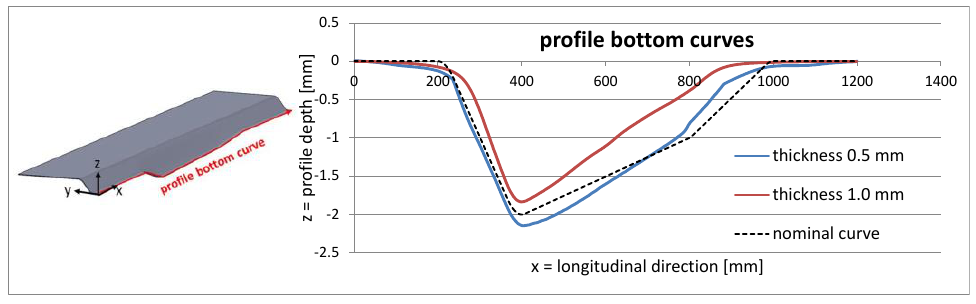
Figure 22. Resulting profile bottom curves with workpiece thickness variation.